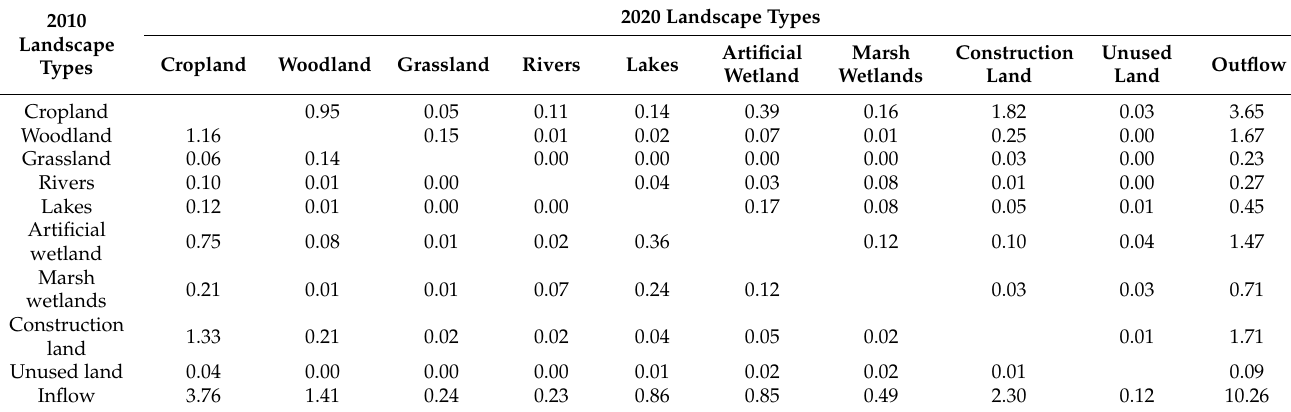
Table 2. Landscape flow transfer matrix, 2010–2020 (unit: %).